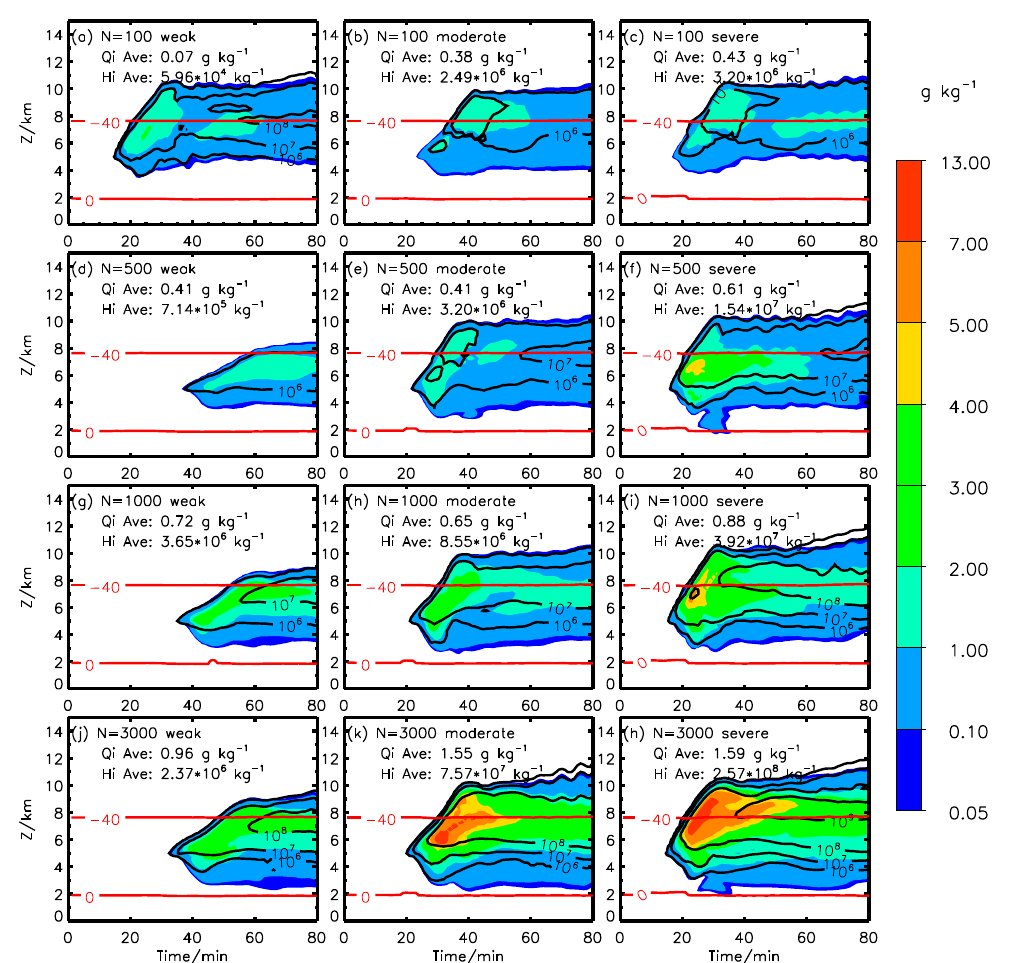
Figure 7. Spatial and temporal distribution of the mixing ratio and the number concentration of ice crystals for initial aerosol concentrations: ( a – c ) 100 cm − 3 , ( d – f ) 500 cm − 3 , ( g – i ) 1000 cm − 3 , ( j – l ) 3000 cm − 3 ; the red solid line represents the isotherm ( − 40 and 0 ◦ C); the black contour respectively represents: 10 6 , 10 7 , 10 8 , and 10 9 kg − 1 .